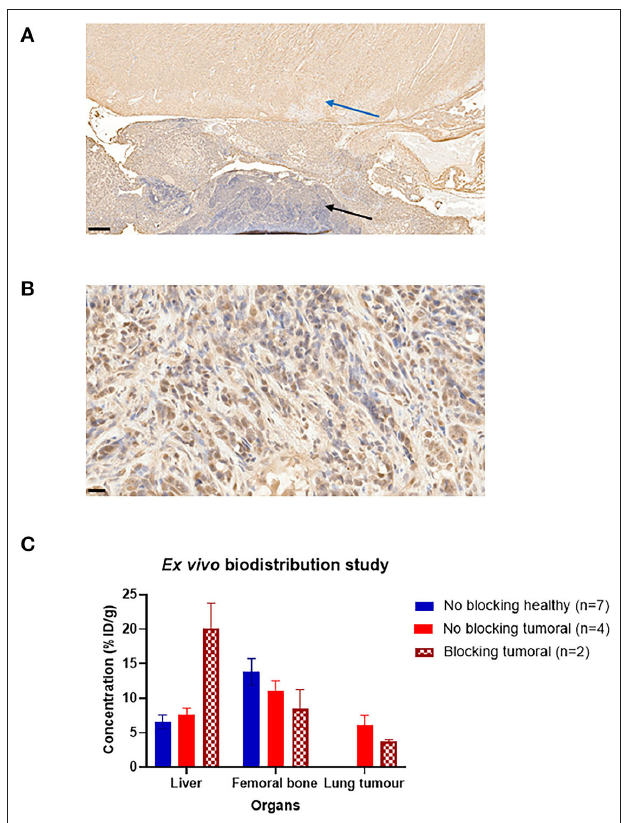
FIGURE 4 | Histological expression of PD-L1 and ex vivo biodistribution study. (A) Histological slide (X5) of lung cancer-grafted mice 10 day after tumour induction. Blue arrows indicate the healthy lung tissue, black arrows indicate the tumoural tissue, black bar indicate the scale bar (200 µ m). (B) On the same histological slide (X40), expression of PD-L1 is revealed by DAB around tumoural cells, black bar indicate the scale bar (20 µ m). (C) Ex vivo biodistribution study in 3 groups: blocking tumoural group (co-injection of 500 µ g of anti-PDL1), non-blocking healthy, and tumoural group.